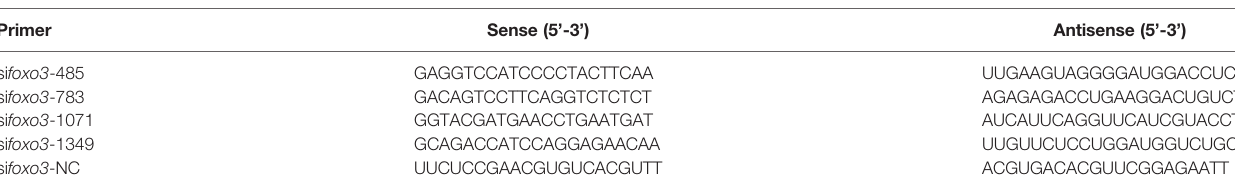
TABLE 2 | SiRNA sequences.